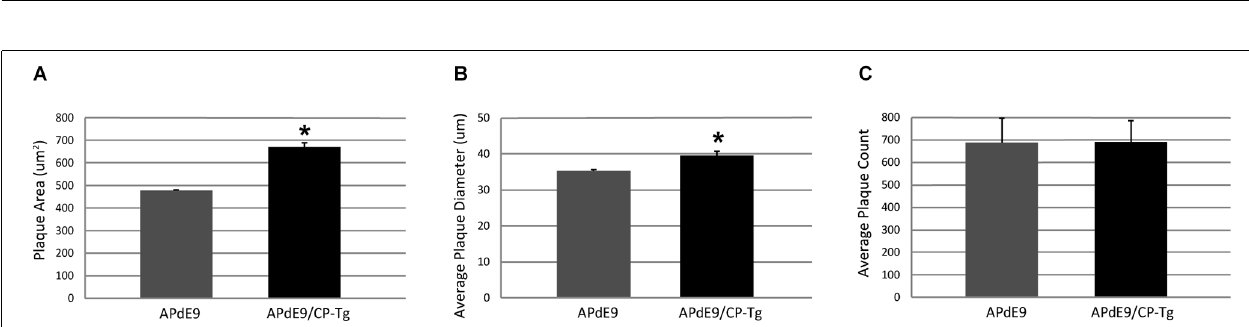
FIGURE 6 | Prostacyclin overexpression increases plaque area and diameter in the brains of APdE9 mice. Measurements in five sections of the whole cortex determined (A) average plaque area, (B) average plaque diameter, and (C) cumulative plaque count per subject. Bars are means ± SEM, n = 10 mice per group. * p < 0.05 compared to APdE9 control mice. A one-way ANOVA was used to determine significant differences.